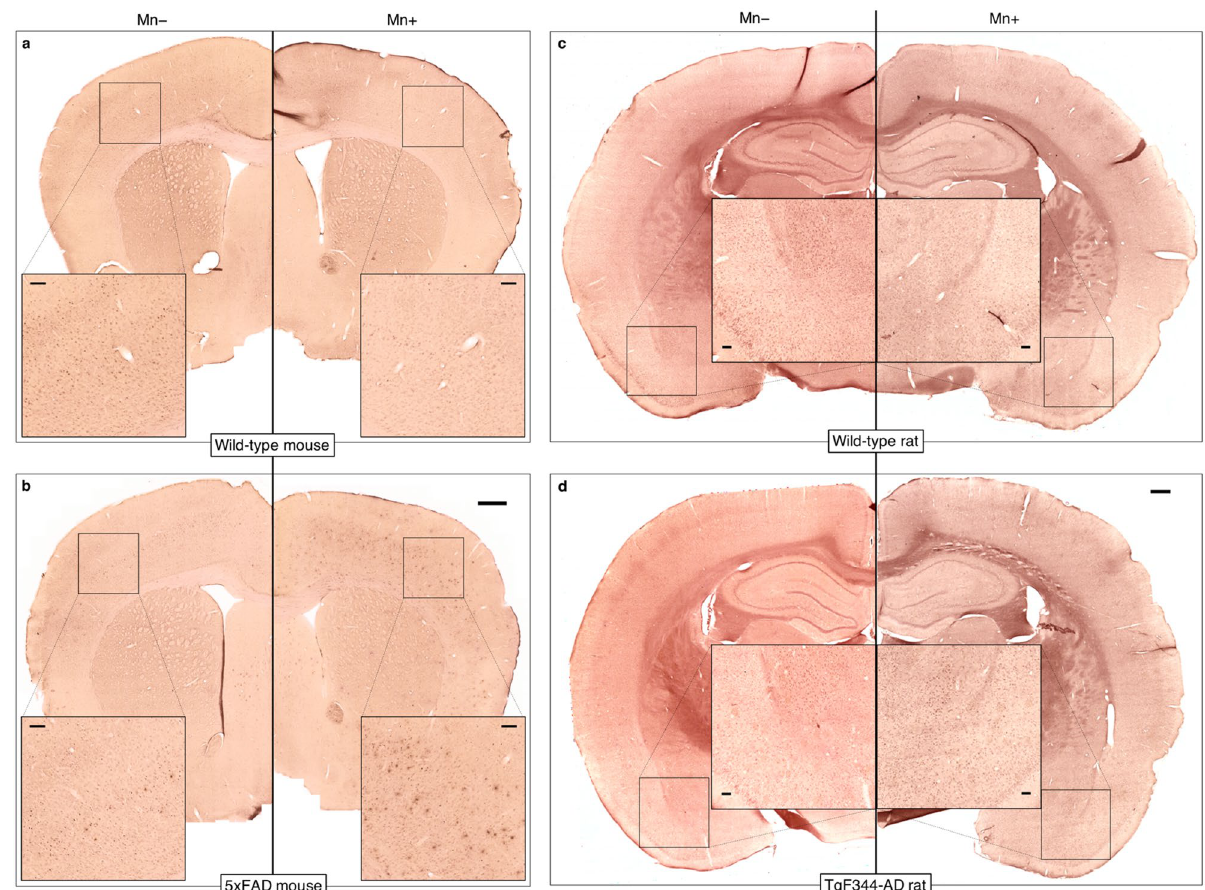
Figure 5. Alizarin Red staining shows subcutaneously administered manganese binds to Aβ plaques in 5xFAD but not TgF344-AD brains. Alizarin Red binds to calcium and, because of their chemical similarity, manganese. ( a ) Alizarin Red staining appears similar in wild-type brains that were MnCl 2 -naïve (Mn−) and treated with MnCl 2 (Mn+). ( b ) In the Mn− 5xFAD brain, some plaques or plaque-like structures in the cortex and septum were stained. Many more plaques were stained in the Mn+ 5xFAD brain, suggesting that the injected manganese bound to the plaques. ( c , d ) Alizarin Red staining appears similar in ( c ) wild-type and ( d ) TgF344-AD brains that were manganese-naïve (Mn−) and treated with MnCl 2 (Mn+). Unlike in the 5xFAD mouse brains, there is no evidence that exogenously administered manganese bound to amyloid plaques in TgF344-AD rat brains. Both whole-section scale bars = 500 μm, and all inset scale bars = 100 Mn(II) uptake as an indirect marker of amyloid plaque burden. While MnCl 2 cannot enable the kind of high-resolution imaging possible with GBCAs, MEMRI did serve another purpose in revealing regional increased Mn(II) uptake and retention in transgenic AD animals compared to wild-types. Previous MEMRI studies have also reported increased Mn(II) in AD mouse models including the 5xFAD model used here, attrib- uting it to neuronal dysfunction and hyperactivity 10,11 . This is consistent with the results of Busche et al. who, through in vivo measurements of spontaneous Ca 2+ transients in individual neurons, found hyperactive cortical neurons in the close vicinity (within 60 μm) of Aβ plaques in the APP23xPS45 mouse model of AD 31 . Manga- nese can also accumulate in microglia and astrocytes via phagocytosis 32 or divalent metal transporters 33 . Given this and the well-known association between inflammation, microglia, and amyloid plaques in AD 34 , glial acti- vation and recruitment to plaques may have contributed to the increased Mn(II) uptake in AD animals. We present evidence of another potential mechanism by which Mn(II) retention was enhanced in 5xFAD mice. The increased R1 norm in brain regions of high plaque load, in conjunction with Alizarin Red staining of plaques in Mn+ but not Mn− 5xFAD mice (Fig. 4a,b), suggests that accumulation of the injected Mn(II) in these regions was increased by direct binding of Mn(II) to plaques. This is supported by recent studies that showed that Mn(II) binds to Aβ with a weak binding affinity that does not affect the protein’s aggregation 35,36 . However, Alizarin Red staining of the TgF344-AD rats brains showed that Mn(II) does not have the same affinity to all plaques (Fig. 4c,d). Moreover, while the plaque load in TgF344-AD rats was equally high in the hippocampus, the increased R1 norm was localized to the rhinencephalon. Together, these results indicate that Mn(II) accumulation was increased in the TgF344-AD rat rhinencephalon due to neuronal dysfunction rather than Mn(II) binding to Aβ.